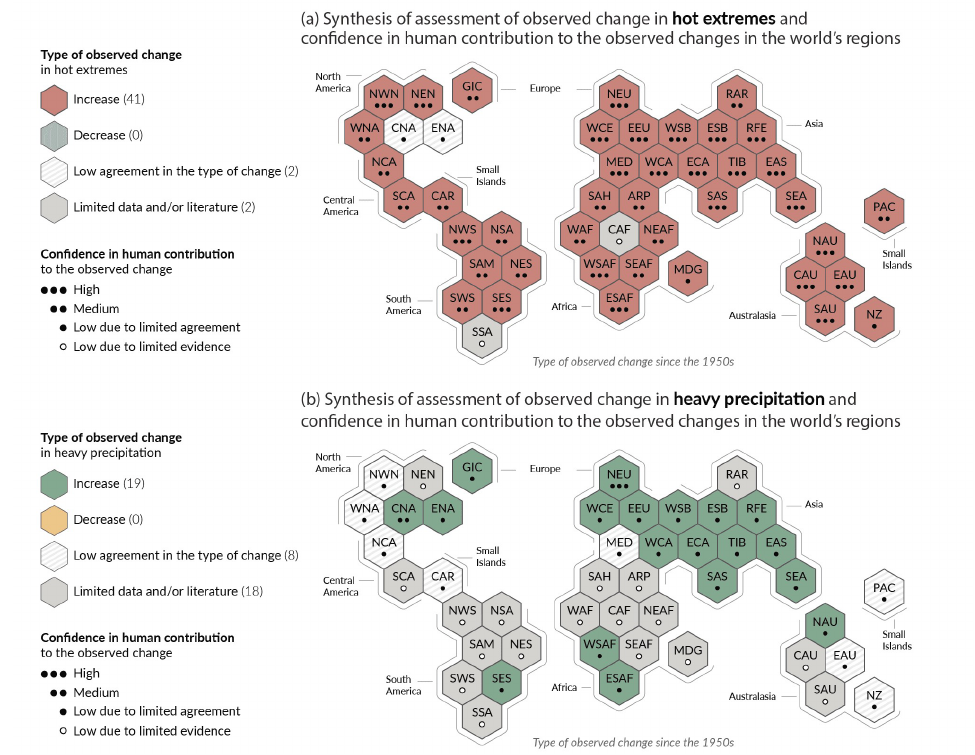
Figure 2. Synthesis of assessed observed and attributable regional changes for hot extremes and heavy precipitation, demonstrating the diversity of regional and modal changes